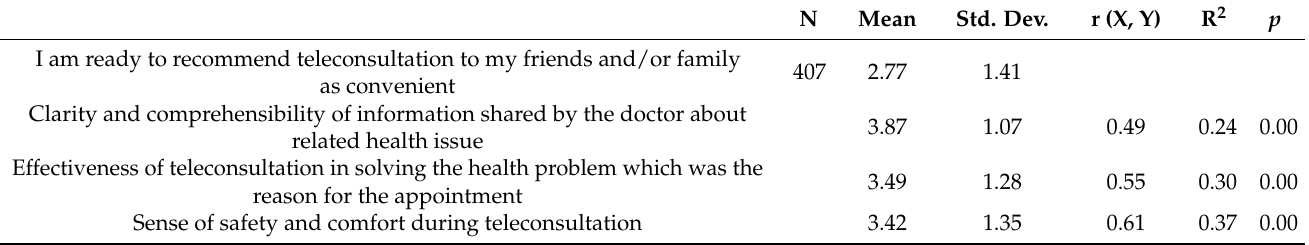
Table 3. Table of correlations of the components of the overall assessment of effectiveness and willingness to recommend teleconsultation to family and